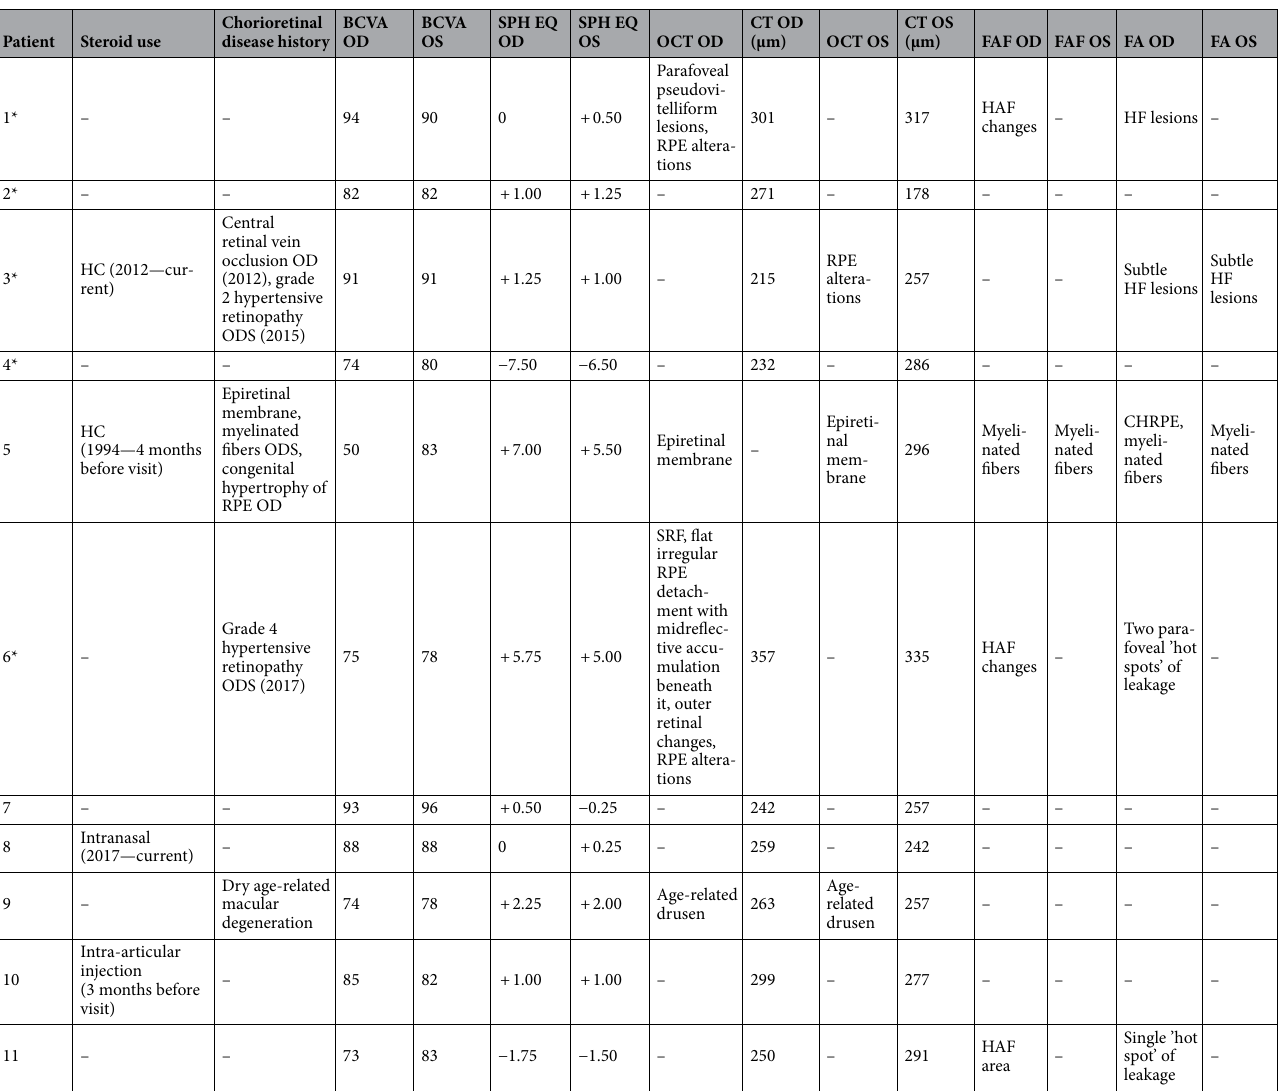
Table 2. Ophthalmological characteristics of patients with active Cushing’s syndrome. * = 2 or more visits. BCVA best-corrected visual acuity, CHRPE congenital hypertrophy of the retinal pigment epithelium, CRVO central retinal vein occlusion, CT subfoveal choroidal thickness, FA fluorescein angiography, FAF fundus autofluorescence, HC hydrocortisone, HF hyperfluorescent, HAF hyperautofluorescent, OCT optical coherence tomography, OD right eye, OS left eye, RPE retinal pigment epithelium, SPH EQ spherical equivalent of the manifest refraction, SRF subretinal